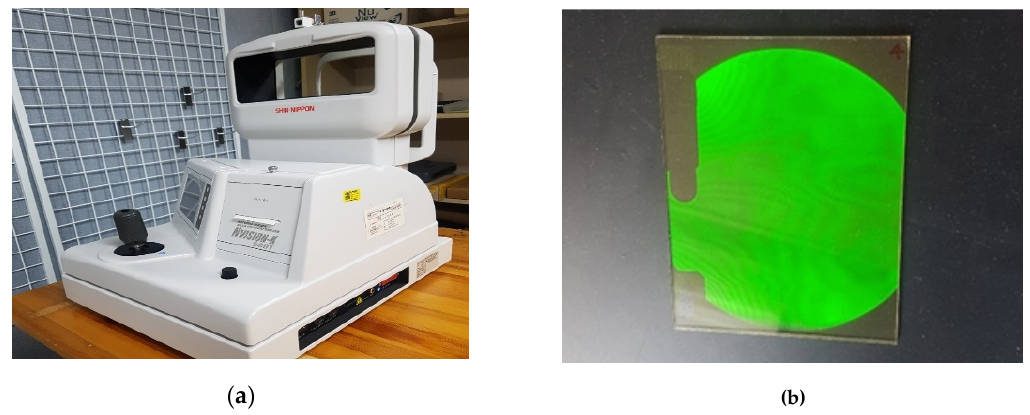
Figure 7. Main device for measuring accommodative response: ( a ) autorefractor, and ( b ) HOE screen.